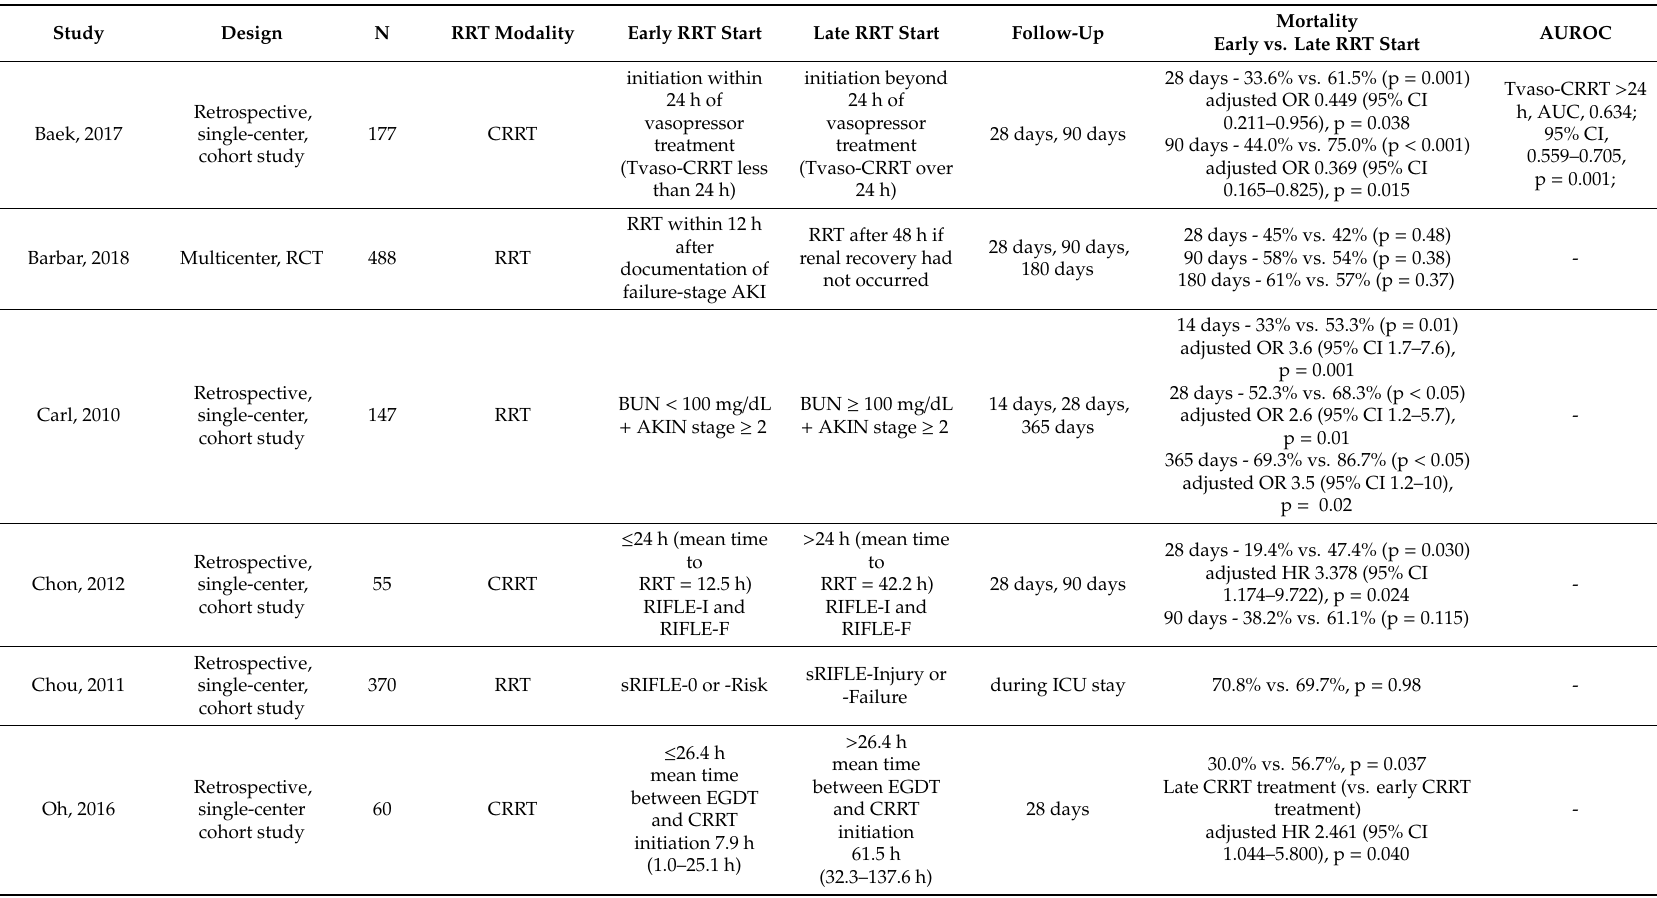
Table 2. Trial summary characteristics reporting data on early vs. late renal replacement therapy